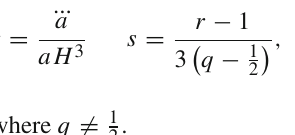
Fig. 6 The plots of NEC, SEC and DEC for the model λ = − 130 different phases of the evolution of the deceleration param- eter and concluded that the deceleration parameter alters its sign from positive to negative, corresponding to high red- shift to low redshift, respectively. The phase transition of the deceleration parameter provides hope to discover the source of the recent acceleration. Through the requirement of a more general dark energy model other than (cid:3) CDM and the devel-